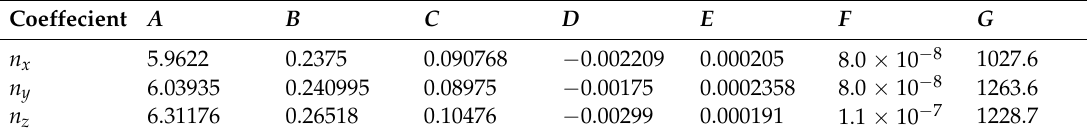
Table 4. Constants in Equation (4).